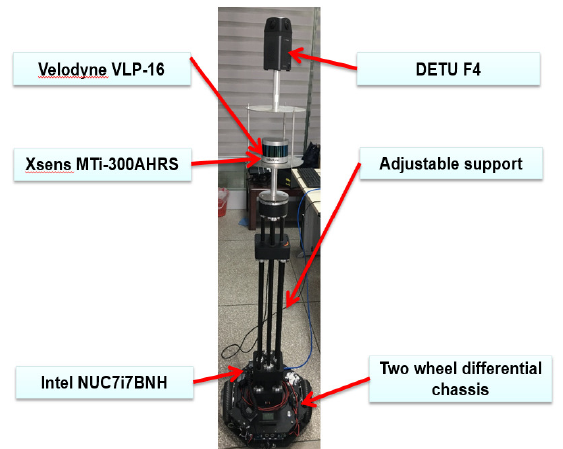
Figure 1. Snapshot of the low cost multi-sensor robot laser scanning